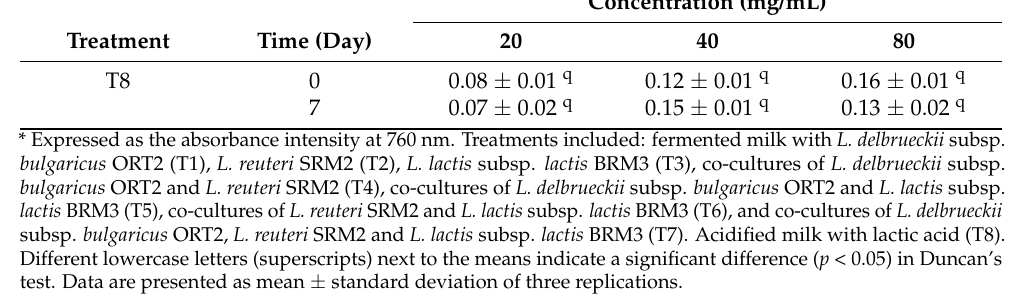
Table 3. Cont. Treatment Time